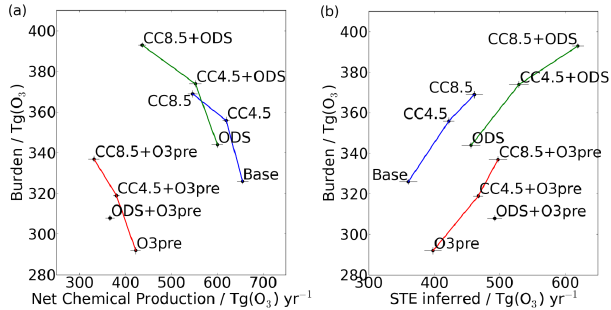
Figure 4. Tropospheric ozone burden against (a) NCP and (b) STE. Connecting lines are drawn between experiments which differ only in their climate states. Error bars denote the 5–95% confidence in- terval, calculated as ± 1.96 times the standard error in the